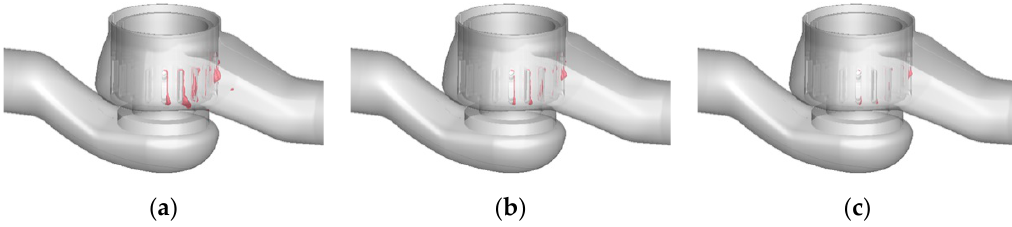
Figure 7. Water vapor distribution in two-cage globe valve with different outlet pressure: ( a ) 0.15 MPa; ( b ) 0.20 MPa; ( c ) 0.25 MPa.